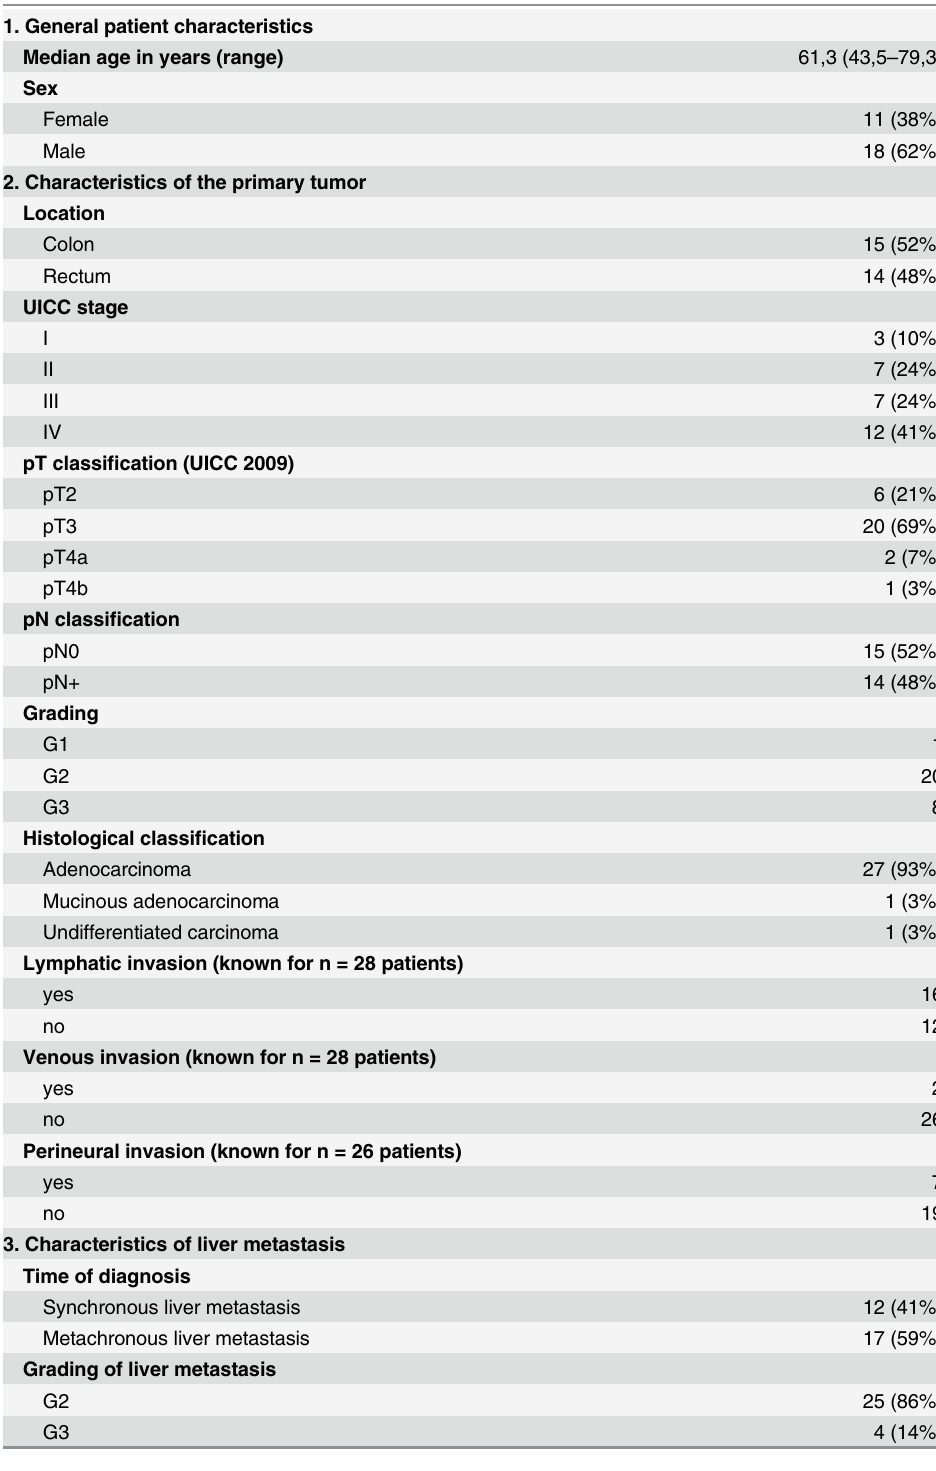
Table 1. Patient